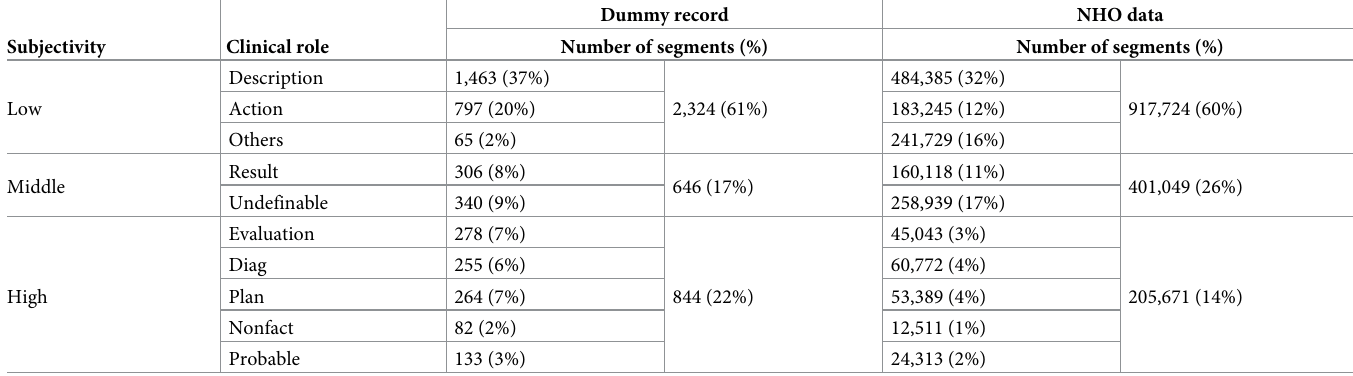
Table 2. Distribution of the clinical role and subjectivity labels. The labels in the dummy record were manually annotated by clinical workers and the NHO data were automatically